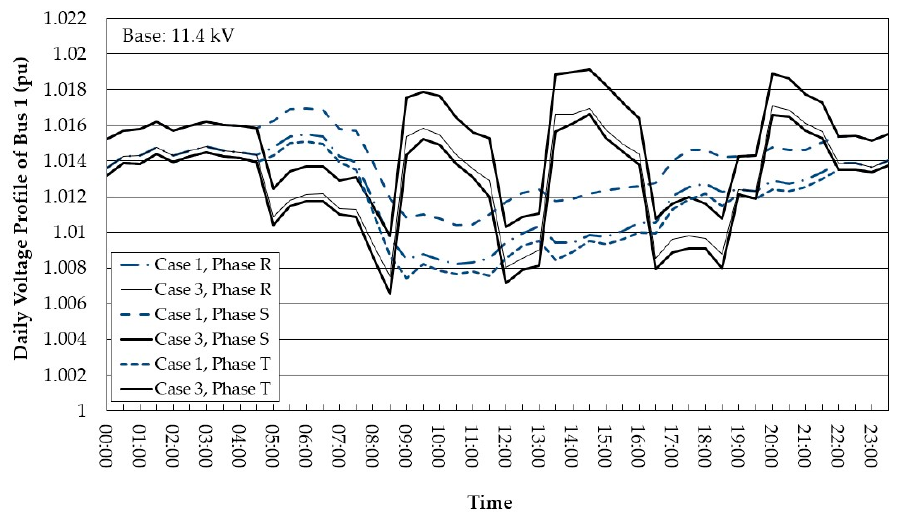
Figure 15. Voltage variation comparison on Bus 22 for Case 1 and Case 2.